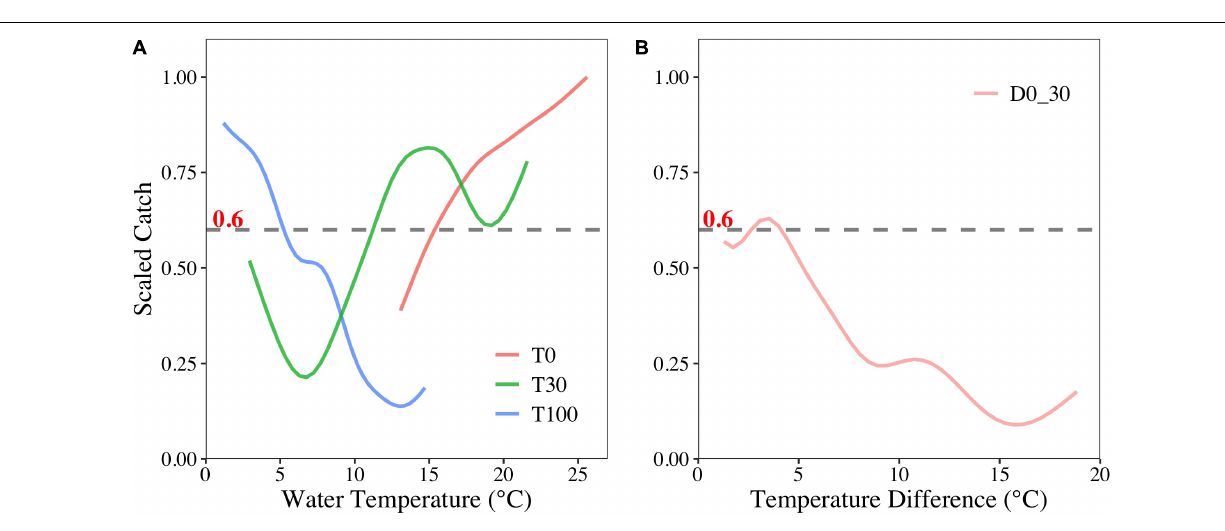
FIGURE 4 | Sensitivity analyses of T 0 , T 30 , T 100 (A) , and D 0 – 30 (B) on the O. bartramii fishing ground in the Northwest Pacific